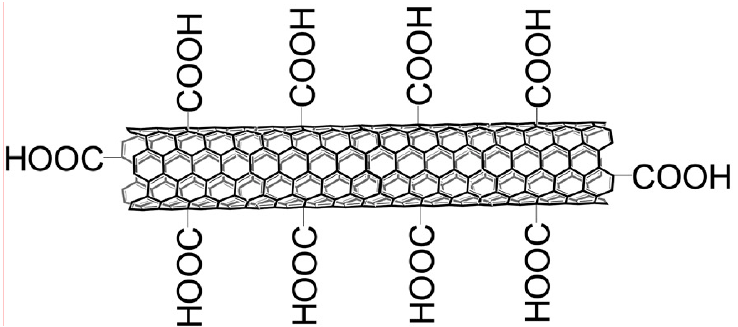
Figure 7. Illustration of the attachment of oxygen containing groups during the oxidation of MWCNTs.